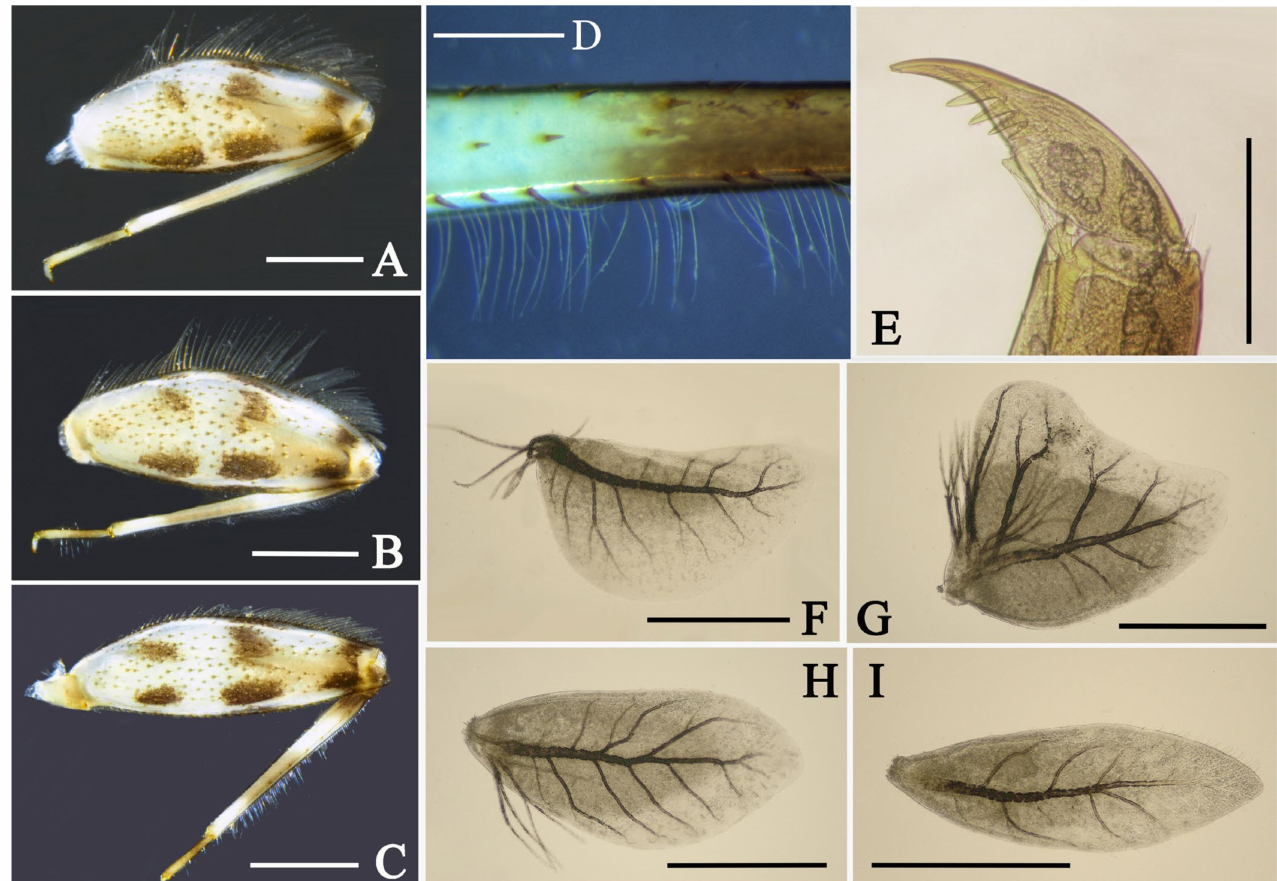
Figure 4. Nymphal structures of Maculogenia ngi (digital photos): ( A ) foreleg; ( B ) midleg; ( C ) hind- leg; ( D ) hindleg tibia; ( E ) foreleg claw; ( F ) gill I; ( G ) gill II; ( H ) gill VI; ( I ) gill VII. Scale bars: ( A – C ) = 1.0 mm; ( D , G , I ) = 0.3 mm; ( E ) = 0.1 mm; ( F , H ) = 0.5 mm. Imago: pale body with dark stripes and dots (Figures 5, 6 and 7D); mesothoracic furcasternum parallel (Figure 7B); first segment of foretibiae of male ca. 1/7 × second one (Figure 7C); mid- and hindtarsi less than 1/2 × tibiae (Figure 7K,L); crossveins of wings normal, those of female wings with brown cloud (Figure 7F–I); styliger plate concave, apical segment of forceps slightly shorter than previous one; penes almost fused totally, with a pair of median titillators but without any other spines (Figure